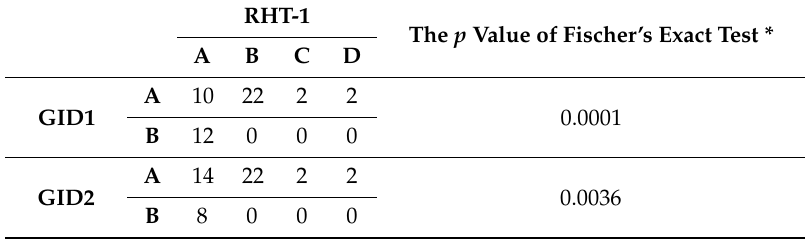
Table 6. Joint finding of the GID1 and GID2 protein isoforms in Ae. tauschii accessions. GID1 The p Value of Fischer’s Exact Test A B